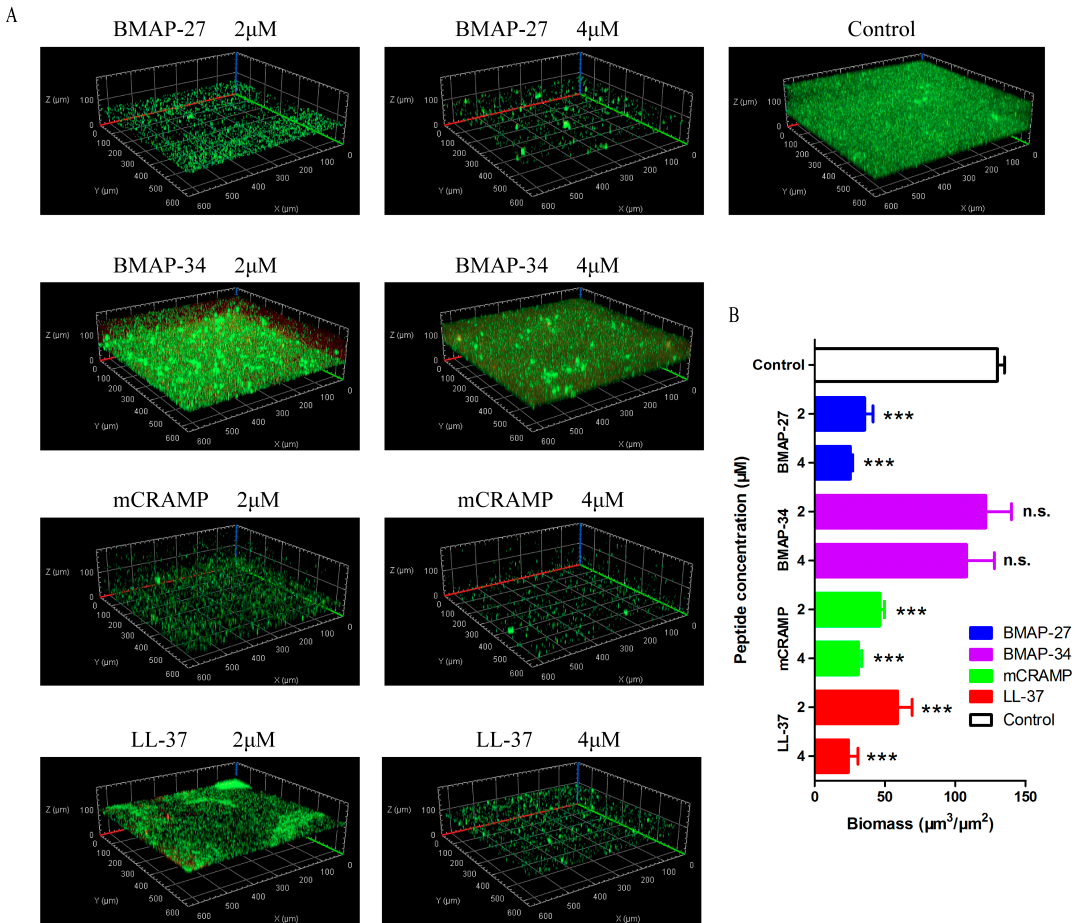
Figure 5. Mammalian cathelicidins BMAP-27, mCRAMP and LL-37 inhibit biofilm formation of P. aeruginosa . ( A ) Representative confocal microscope images of P. aeruginosa biofilm developed for 36 h at the treatment with the indicated concentrations of each peptide. ( B ) Quantification of biofilm biomass determined by analysis with COMSTAT. Values represent the mean ± SD from at least five image stacks, *** P < 0.001, n.s. = not significant.